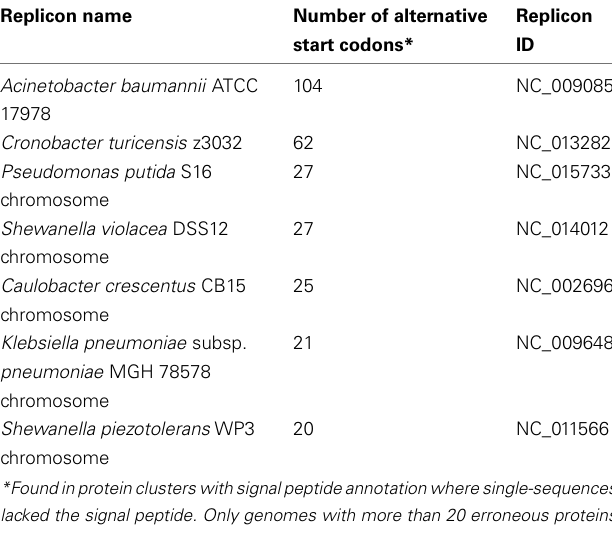
Table 6 | Genomes with multiple signal peptide/start codon errors in secretory clusters.